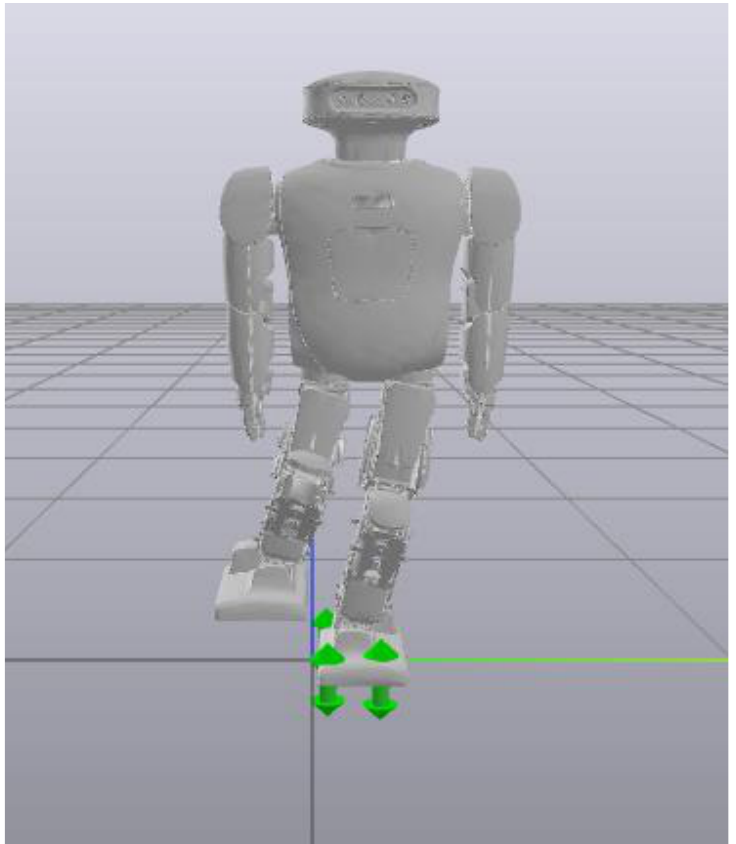
Figure 7. A Drake visualization of Roban standing on a single leg. The green symbols represent the plantar contact force of the robot.